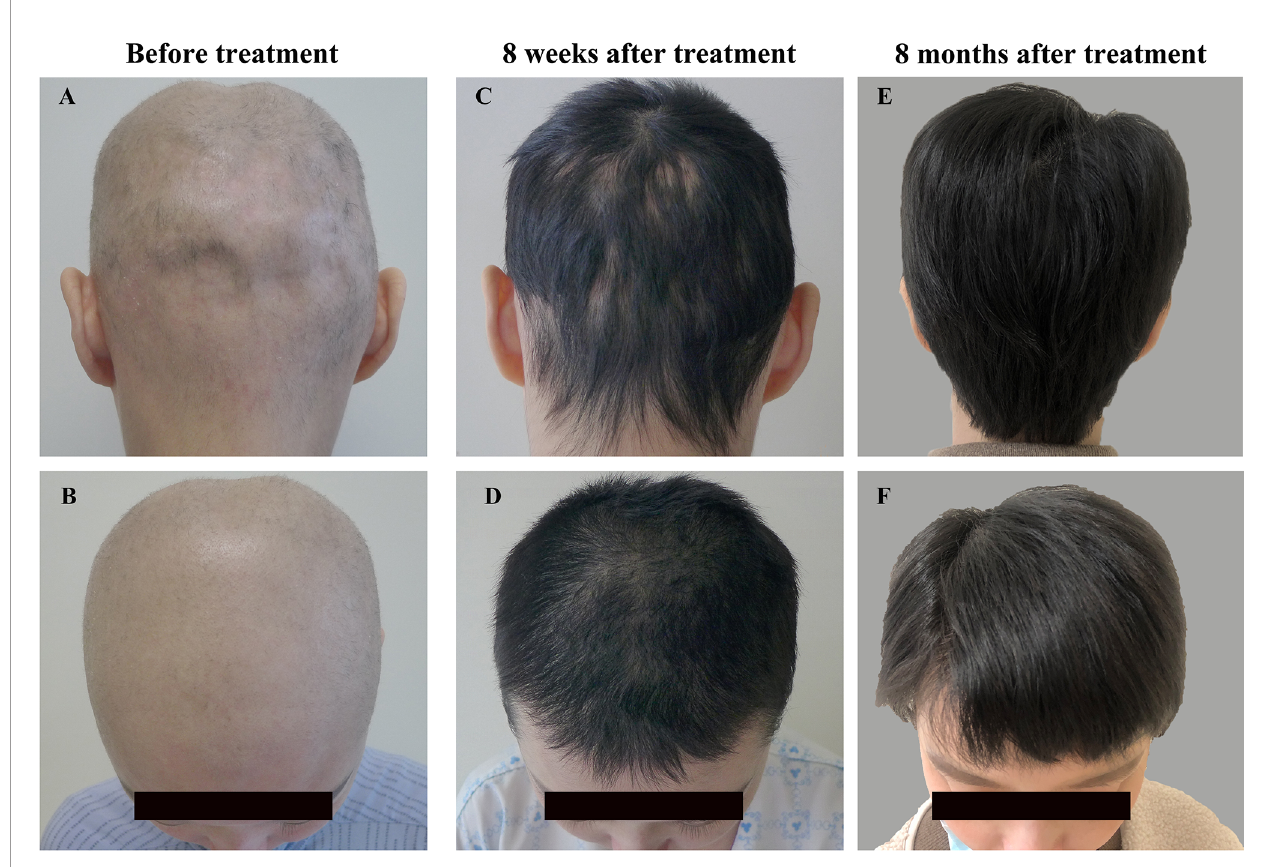
Rash with pruritus, alopecia, hypocomplementaemia, positive ANA and anti-dsDNA antibodies (a diagnosis of SLE was made) Rash and hair loss progressing over several days to nearly the entire scalp